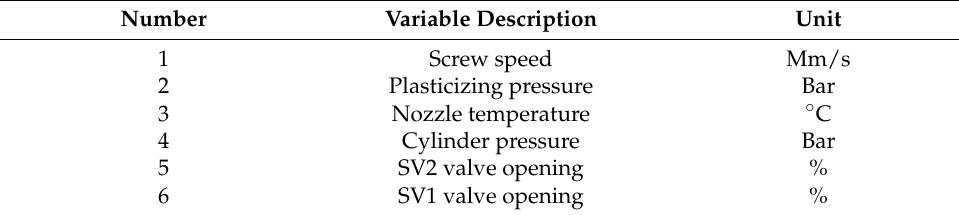
Table 2. Process variables of injection molding process in start-up process.